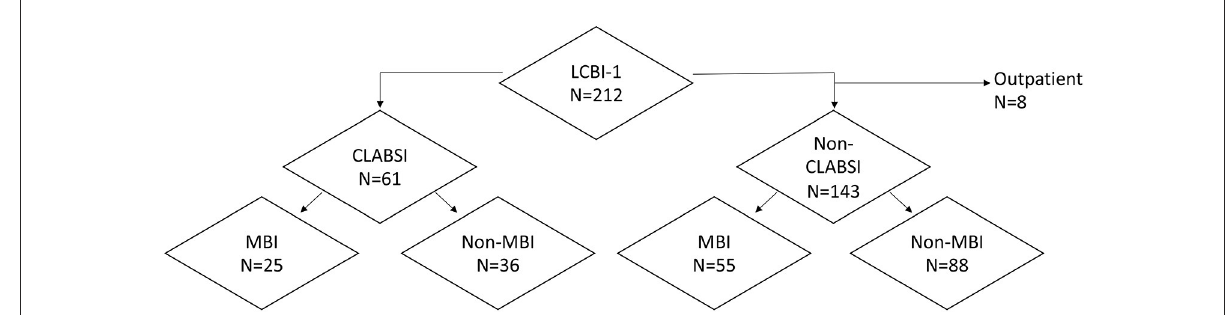
FIGURE1 Distribution of bloodstream infections by Centers for Disease Control and Prevention/National Healthcare Safety Network (NHSN) 2016 surveillance classification type. CLABSI, central line–associated bloodstream infection; LCBI, laboratory-confirmed bloodstream infection; MBI, mucosal barrier injury